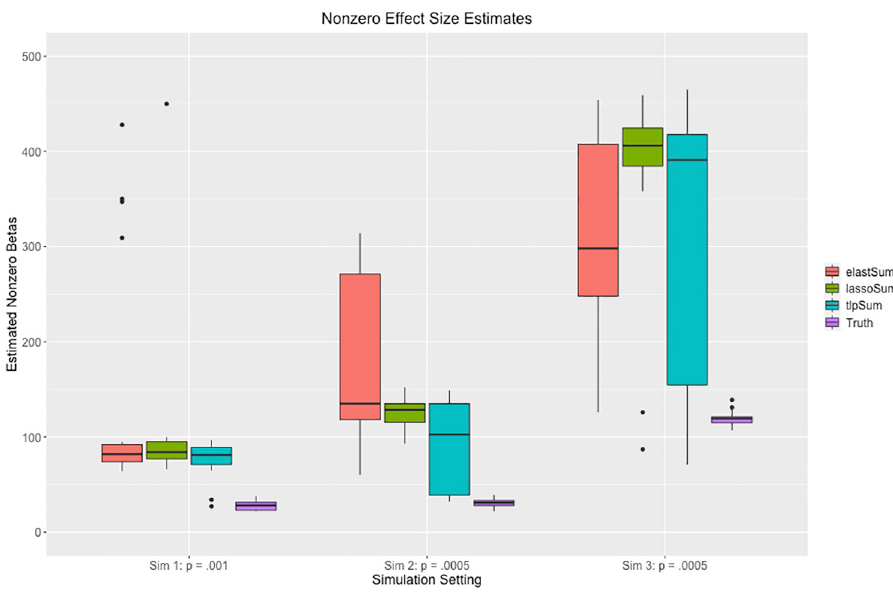
Fig 6. Number of nonzero effect sizes estimated by the three penalized regression methods as compared to the true number of nonzero effects, for the three sparse simulation settings.